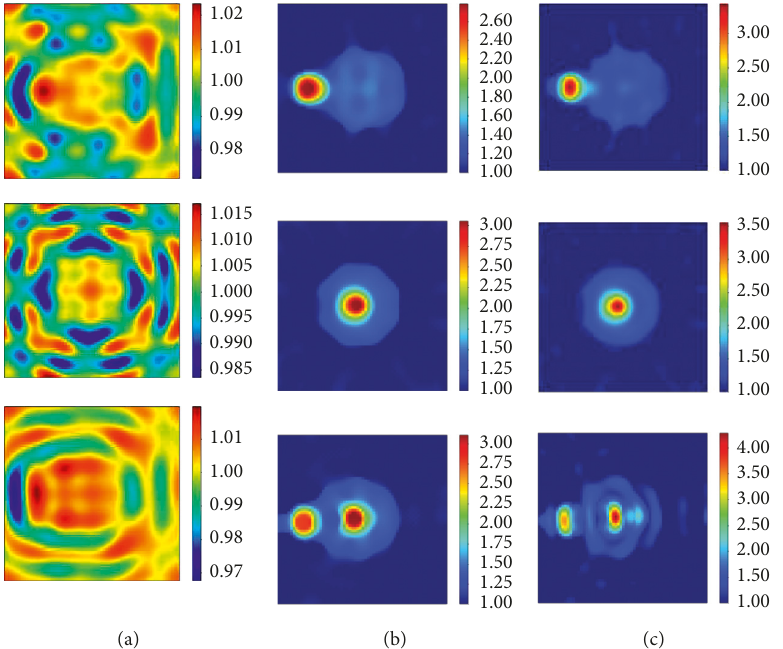
Figure 7: From top to bottom is the inversion results of ‘FoamDielExtTM,’ ‘FoamDielIntTM,’ ‘FoamTwinDielTM’ at 5 GHz. (a) is the BP results, (b) is the MR-IO-CSI results, and (c) is the IO-CSI